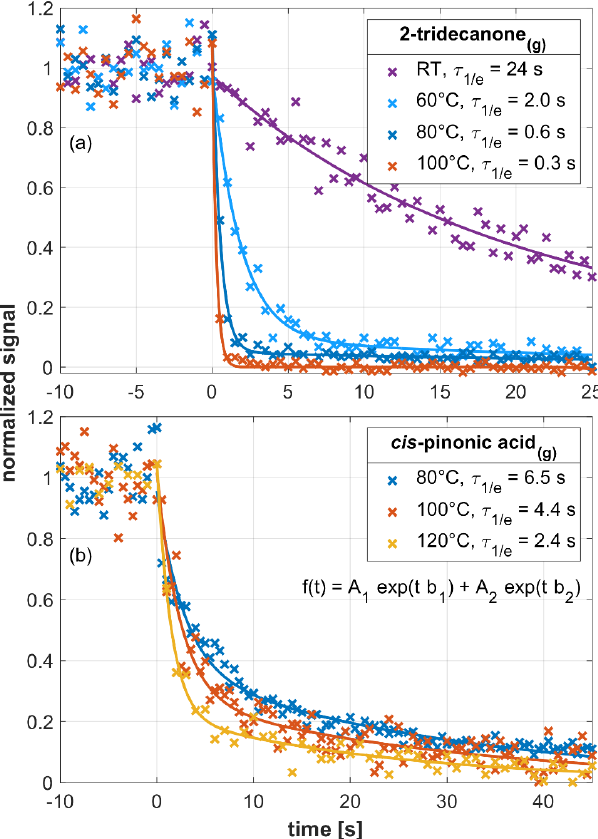
Figure 5. Signal decay as observed in an EVR PTR-MS analyzer for 2-tridecanone ( g ) (a) and cis -pinonic acid ( g ) (b) , respectively, at dif- ferent drift tube temperatures. Initial steady-state mixing ratios were as follows: 2-tridecanone ( g ) , 1–1.3ppbv; cis -pinonic acid, 2.2ppbv. Signals were fitted using a double exponential decay function (see insert in b ). All fitting parameters are listed in Table